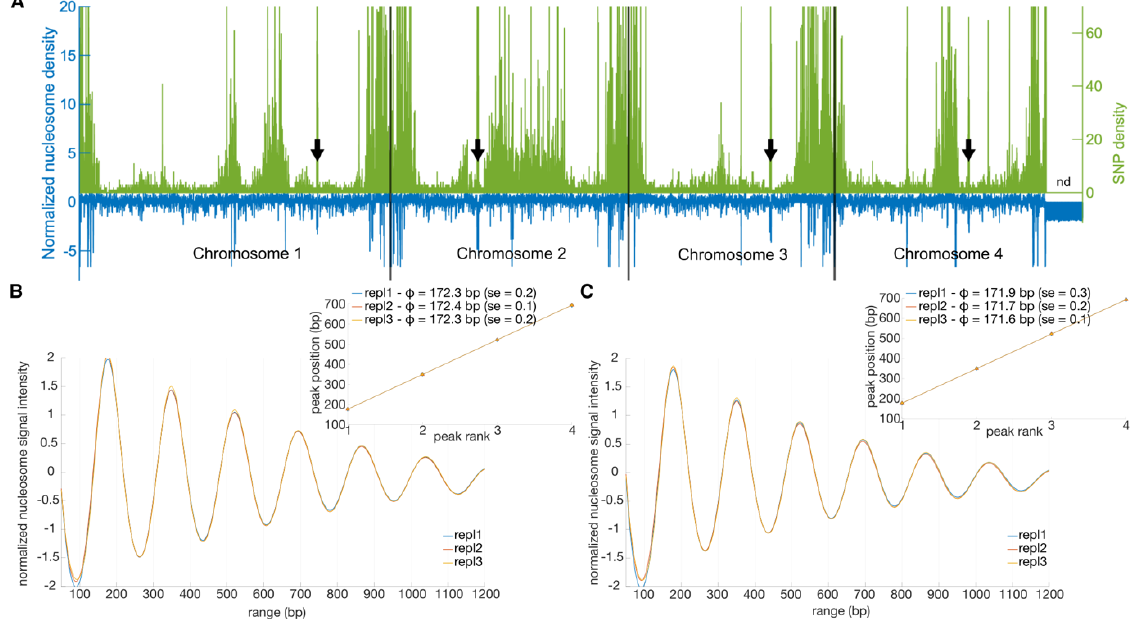
Figure 3: Nucleosome density profiles in Fusarium graminearum . A. Coverage density profiles were computed for non- overlapping 1 kb-long bins along the four chromosomes of F. graminearum . In green are plotted SNP density profiles as previously described (Laurent et al. , 2017). “nd” indicates the highly variable 3’ end of chromosome 4 for which SNP were not called. In blue are plotted the z-scored average nucleosome density profile (see Supplementary Figure 2 for individual replicate plots). Black arrows indicate centromeres (King et al. , 2015); B and C. Nucleosome phasing in polymorphic islands (B) or outside polymorphic islands (C) as previously defined (Laurent et al. , 2017). Main graphs display phase frequencies (y-axis) as a function of position (in base pair; x-axis). Graphs in inserts show peak positions (in base pairs; y-axis) as a function of peak order (x-axis); Phases +/- standard errors (se), R 2 (coefficient of determination), and p -values ( F -test) are determined after linear regression fitting to the first four successive peak positions (see Supplementary Table 3). Repl =